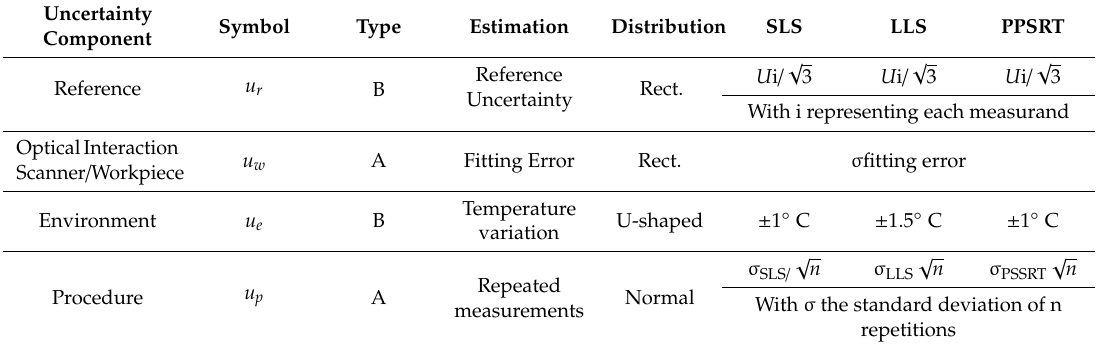
Table 1. Uncertainty budget composition.